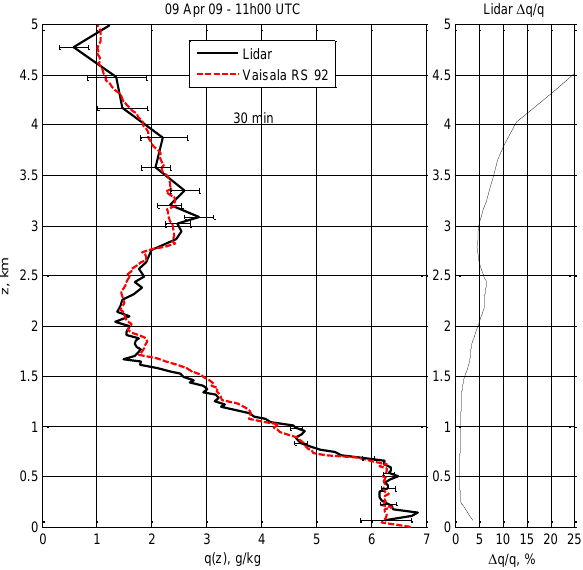
Fig. 13. Left : Daytime profiles of water vapor mixing ratio com- pared to Vaisala RS92 radiosonde launched on 9 April 2009 at 11:00UTC; Right : Lidar statistical error profile.